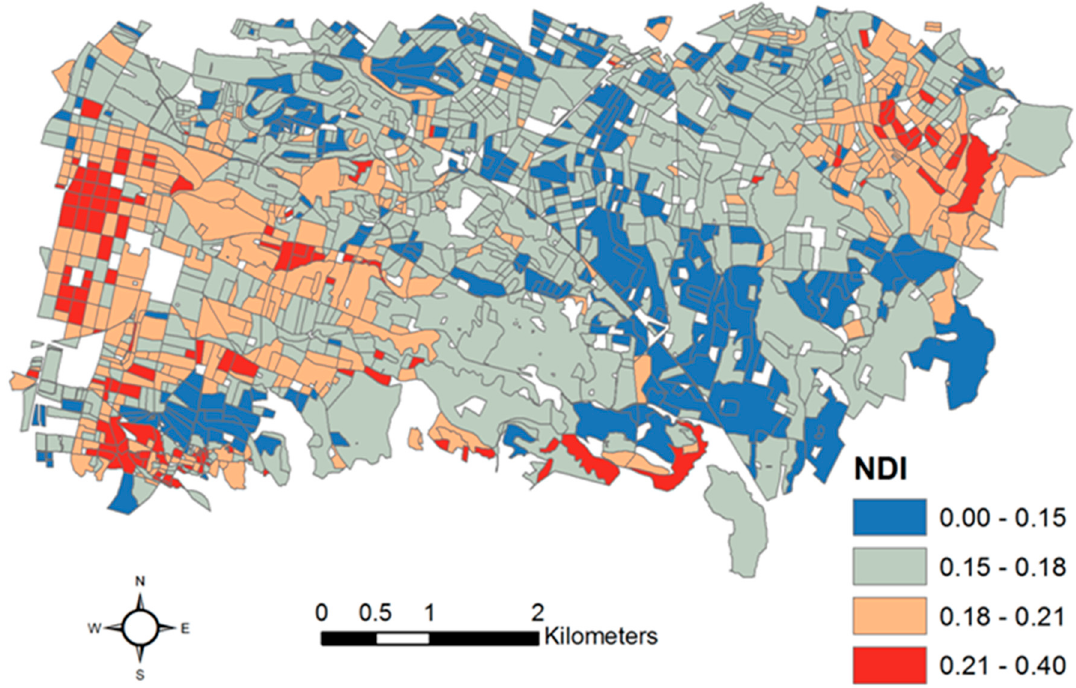
Figure 2. NDI map obtained from pre- and post-seismic GeoEye-1 images over Port-au-Prince.